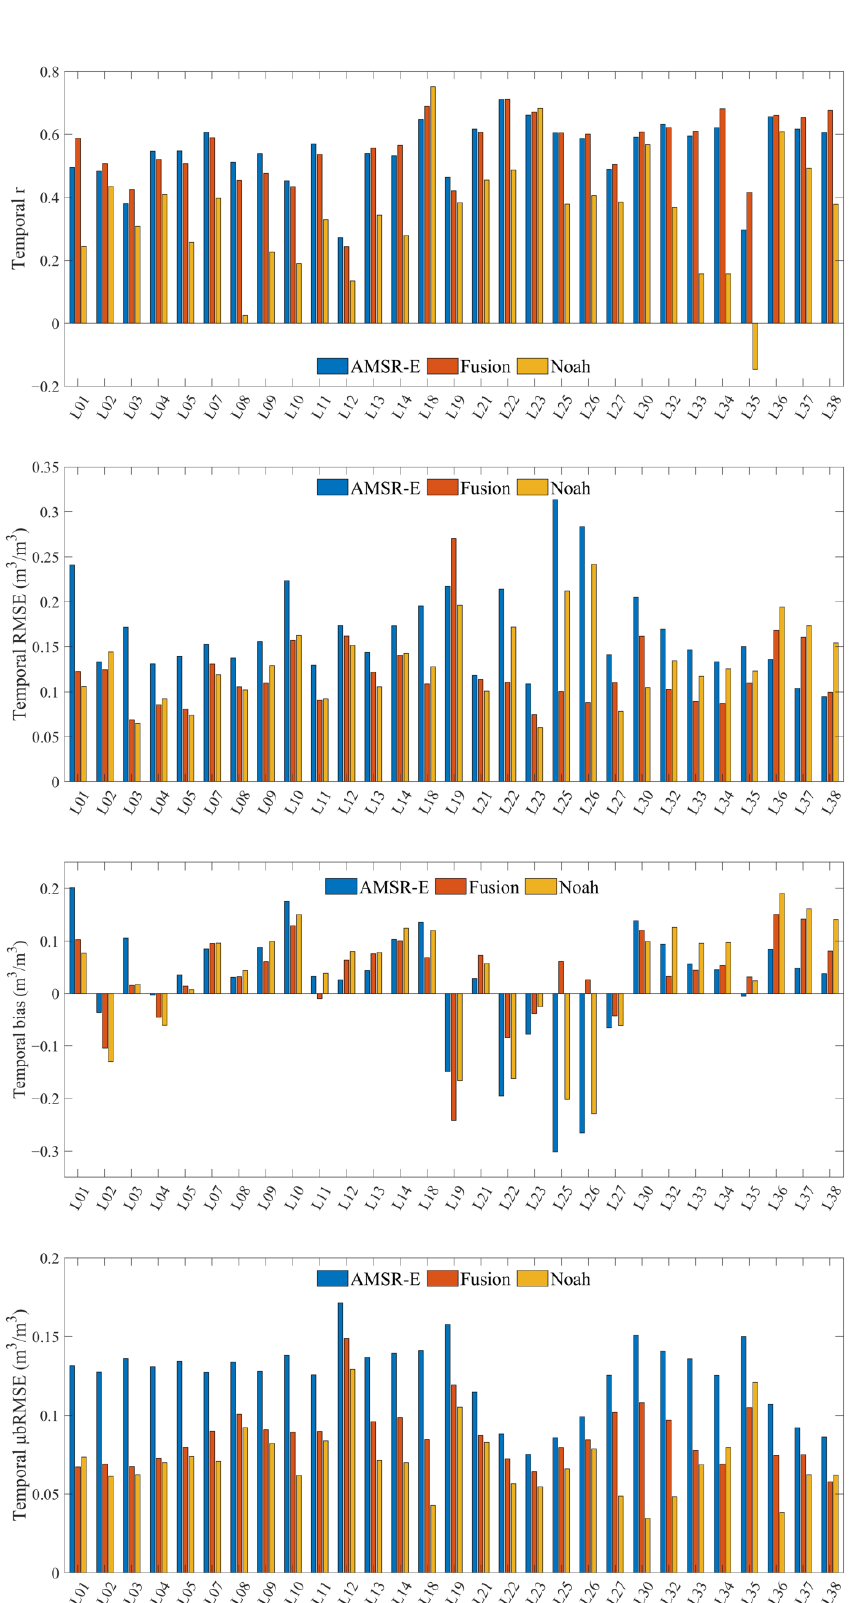
Figure 8. Temporal accuracy evaluation of AMSR-E, Noah, and the fused MODIS SSM against each in situ data at MODIS